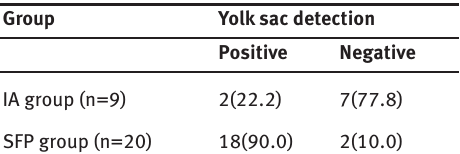
Table 2: Yolk sac detection rate by ultrasonography between IA and SFP groups [n(%)].